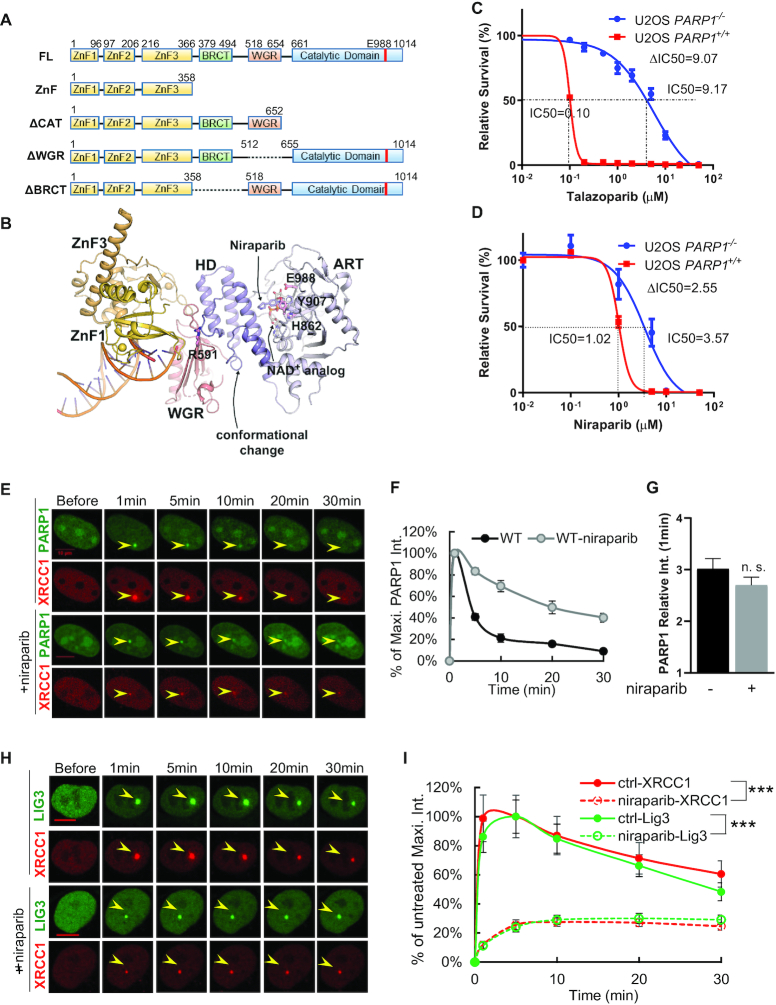
PARP1, but not PARP2, deletion desensitizes cells to clinical PARP inhibitors. (A) Diagrams (not to scale) of full length and truncated human PARP1. (B) The structural model of human PARP1 bound to DNA (PDB-ID: 4DQY (19) ) with PARP inhibitors. We marked the residues at the WGR-HD interface or catalytic triad that are mutated in this study. The structure of the NAD+ analog BAD and Niraparib was fitted into the catalytic center as indicated. (C, D) The sensitivity of parental U2OS cells and PARP1 KO U2OS cells (clone 1) to clinical PARP inhibitor talazoparib (C, dose range 0.1–50 μM) and niraparib (D, 1–50 μM). For the sensitivity curve on panels C and D, one representative result from at least two independent biological repeats were shown. The dots and error bars represent means and standard errors, respectively. The volume of DMSO was <0.1% (v/v) in all experiments. (E) Representative live-cell images for GFP-WT-PARP1 and dsRed-XRCC1 upon laser-induced micro-irradiation (±1 μM niraparib for more than 1 h before irradiation) in PARP1 knockout U2OS cells. The yellow arrowheads point to the area of micro-irradiation. Scale bar = 10 μm. (F) The normalized kinetic curves of GFP-WT-PARP1 foci upon micro-irradiation (±1 μM niraparib). The relative intensity was plotted as the percentage of the maximal relative intensity (achieved at 1 min) for each condition. See methods for details. (G) Quantification of PARP1 foci relative intensity at 1 min after micro irradiation. Two-sided unpaired Student's t-test P = 0.24. (H) Representative live-cell images for GFP-Lig3 and dsRed-XRCC1 upon laser-induced micro-irradiation (±1 μM niraparib for more than 1 h before irradiation) in U2OS cells. The yellow arrowheads point to the area of micro-irradiation. Scale bar = 10 μm. (I) The normalized relativity intensity of GFP-LIG3 and dsRed-XRCC1 foci upon micro-irradiation (±1 μM niraparib). The normalized relative intensity was plotted as the percentage of the maximal relative intensity of untreated (control) cells. See methods for details. For F, G, and I, the dots and bars represent means and standard errors, respectively, from one representative experiment out of 2–4 with n > 8 cells each time with consistent results. The two-sided unpaired Student's t-test, ***P < 0.001 and n.s.: P > 0.05 for maximum foci intensity.